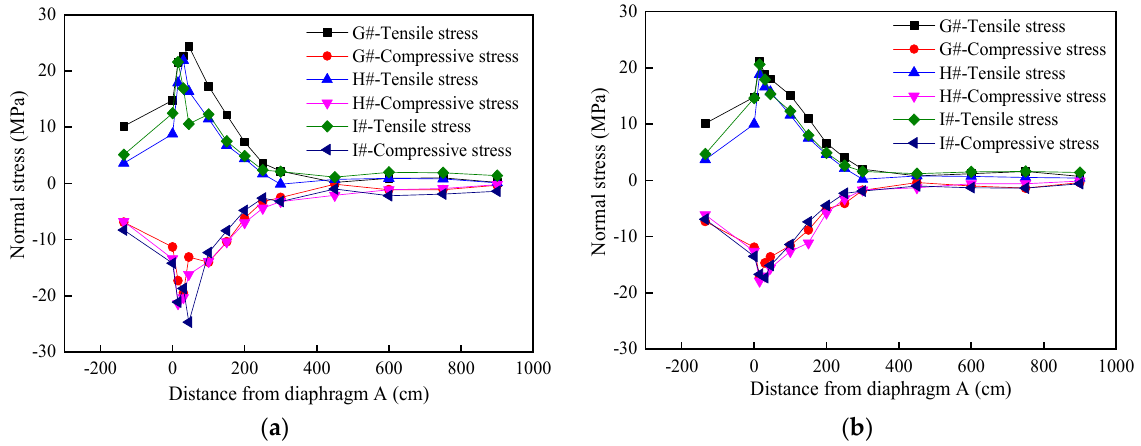
Figure 21. Longitudinal loading 100# diaphragm (steel reinforcement) U rib side stress-load position relationship curve: ( a ) Before reinforcement, ( b ) after reinforcement.